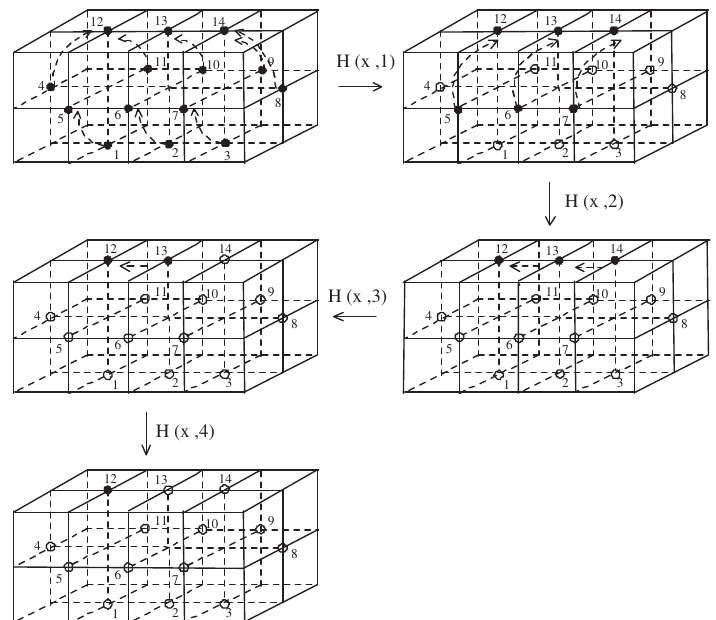
Figure 6. Configuration of the 18-homotopy of (16) involving the 18-contractibility of C 2 of Corollary